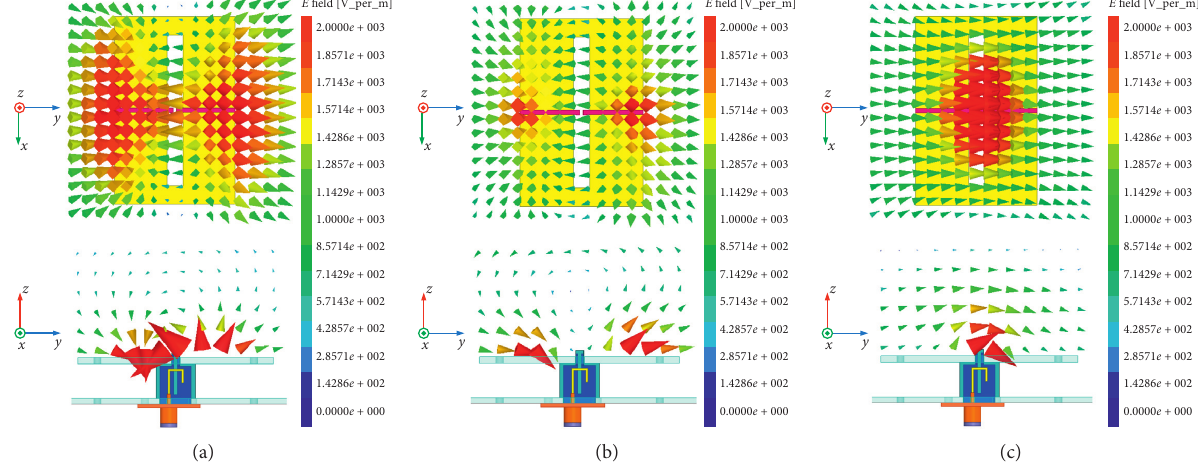
Figure 4: Electric field distributions of the proposed antenna: (a) 3.0GHz, (b) 3.6GHz, and (c) 4.8GHz.